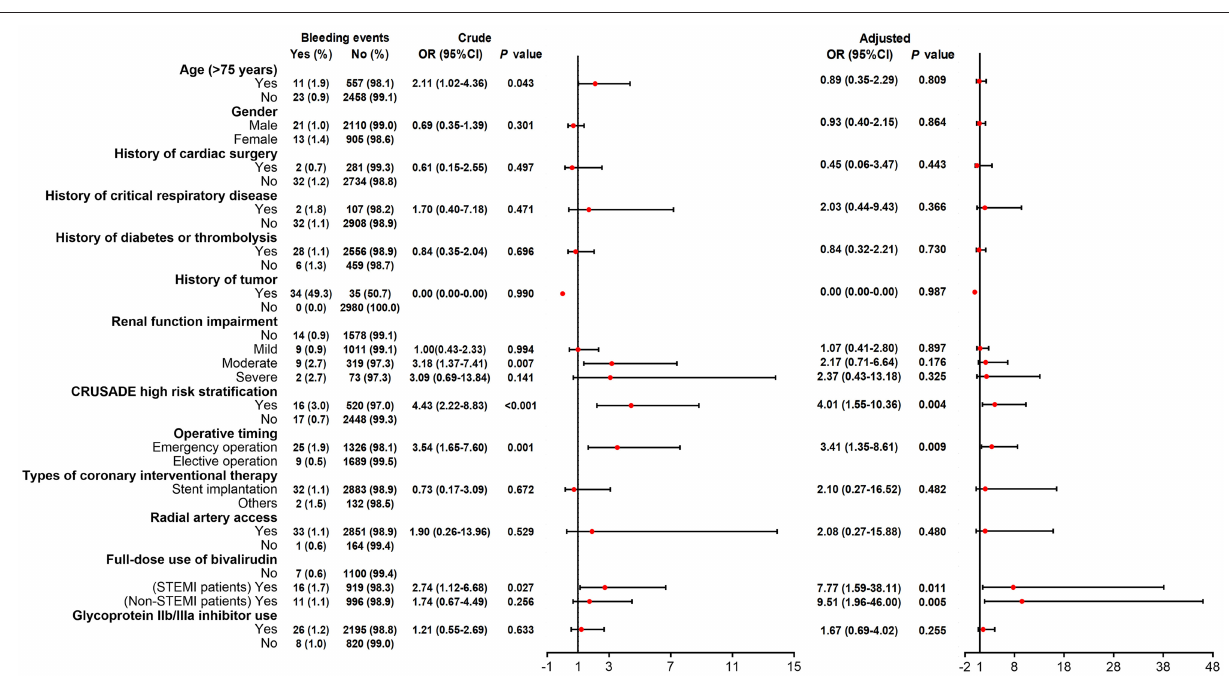
FIGURE 2 | Logistic regression analyses for factors predicting bivalirudin related bleeding events risk. Supplementary Table 5 . In addition, 6 patients experienced one new ADR and 1 patient faced two new ADRs, resulting in 7 (0.23%) patients suffering from new ADRs